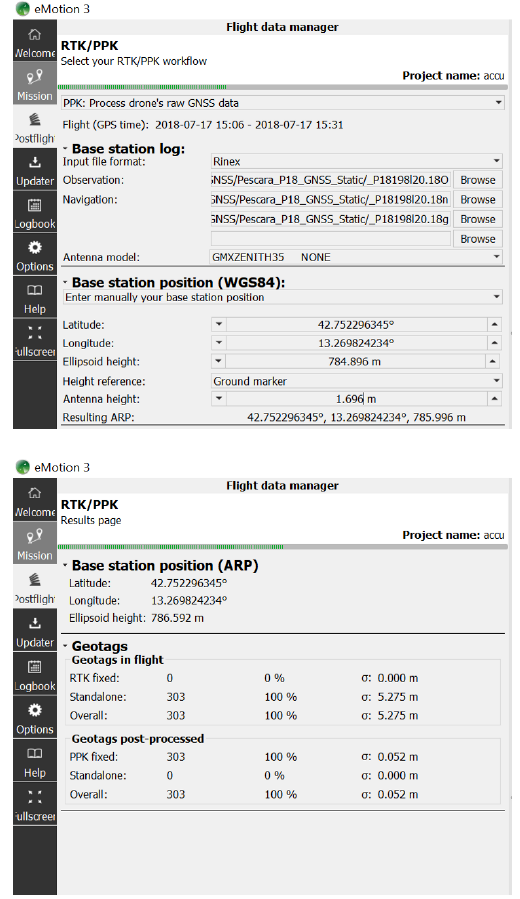
Figure 7. eMotion3 PPK processing windows. The GNSS base station input data: observation, 3D coordinates and antenna height (top). The estimated accuracy of the Geotags after the PPK process (vs the ones measured during the flight,